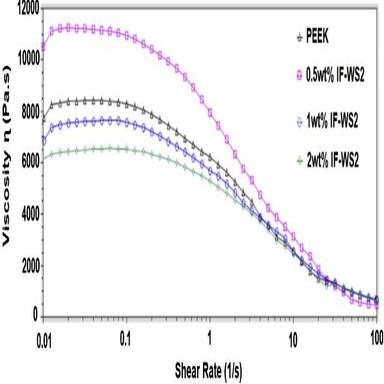
Shear viscosity versus shear rate for PEEK samples containing different amounts of IF-WS2.